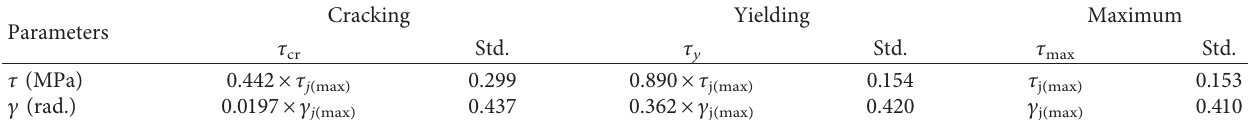
Table 5: Joint panel shear strength-deformation analytical equations developed by Kim and LaFave (2012). Parameters